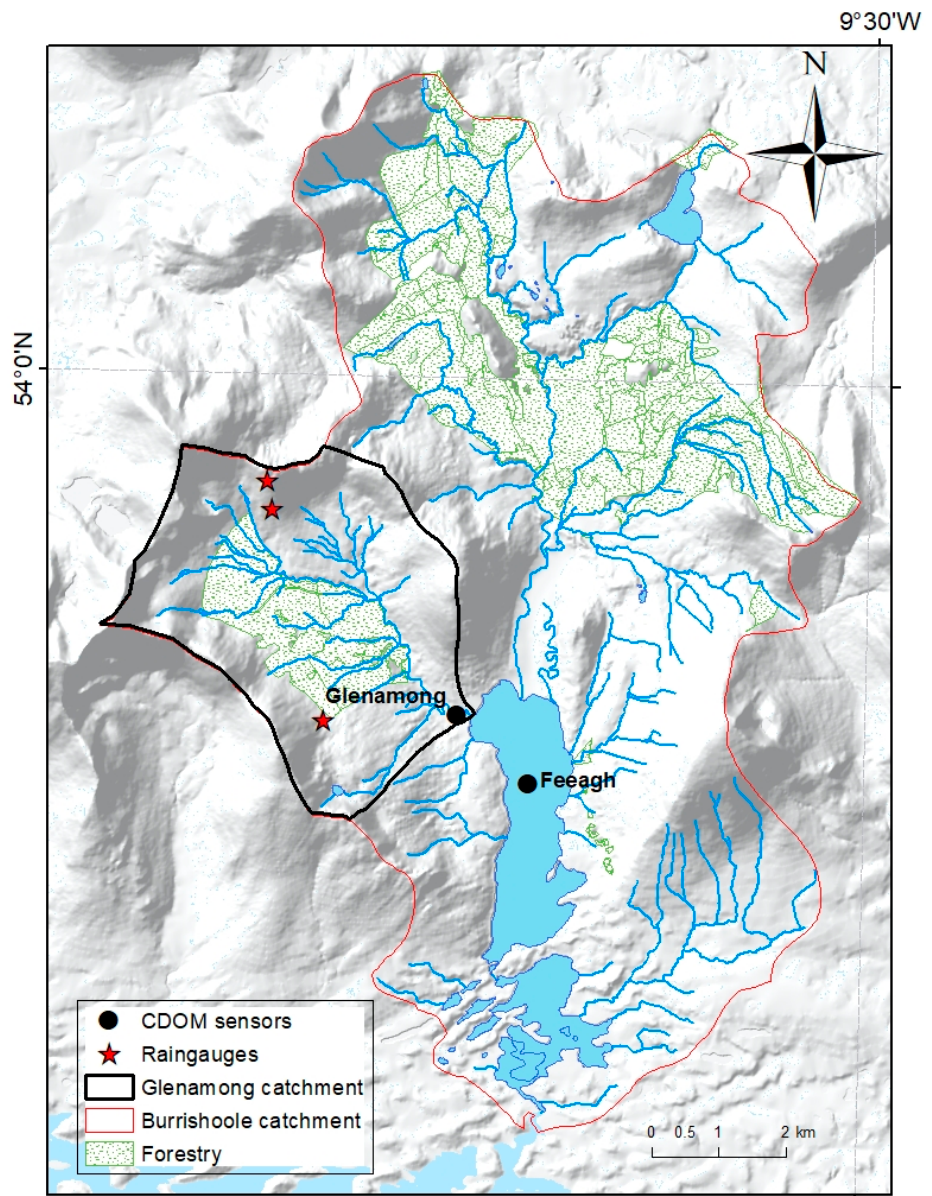
Figure 1. The Burrishoole catchment in Ireland, showing the outlines of the catchment and of the Glenamong River sub-catchment, the locations of the chromophoric dissolved organic matter (CDOM) sensors on the Glenamong and on the lake (Feeagh) and locations of the three Glenamong sub-catchment rain gauges (stars). The areas of coniferous forestry are also indicated.